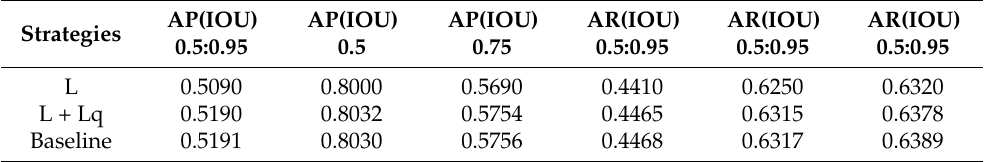
Table 7. Lq loss performance